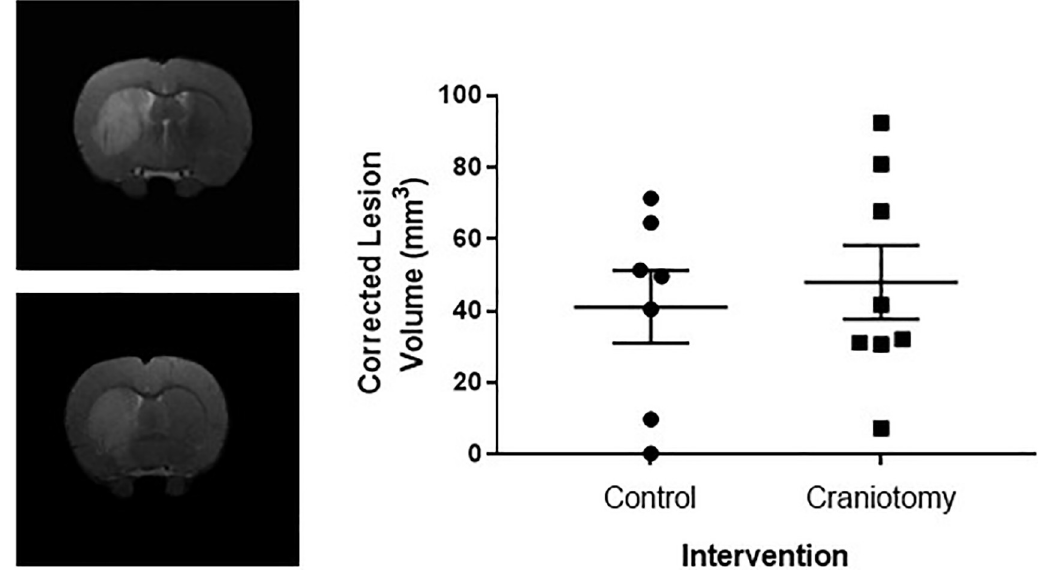
Fig 1. Effect of craniotomy on ischemic lesion volume as calculated from T2-weighted MRI images. (a) Representative T2-weighted MRI coronal images from the control group (a) and craniotomy (b) group of the lesion in the rat brain. (c) Graph showing lesion volume (mm 3 ) and corrected against the size of the contralateral hemisphere to account for swelling. There was no significant difference in lesion volume between groups (control n = 7, craniotomy n =